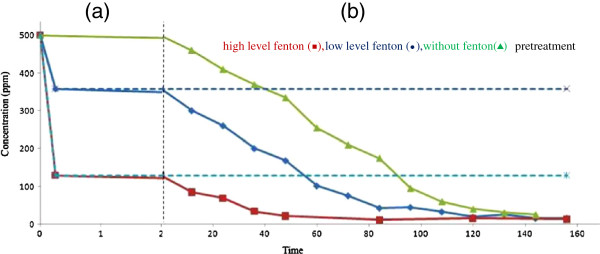
Biotransformation profile of RB5 treated with the combined Fenton–biological process; Fenton reagents with Fe2+: H2O2 molar ratio of 0.5:2.9 (a) in first 2 h; (b) after 2 h.